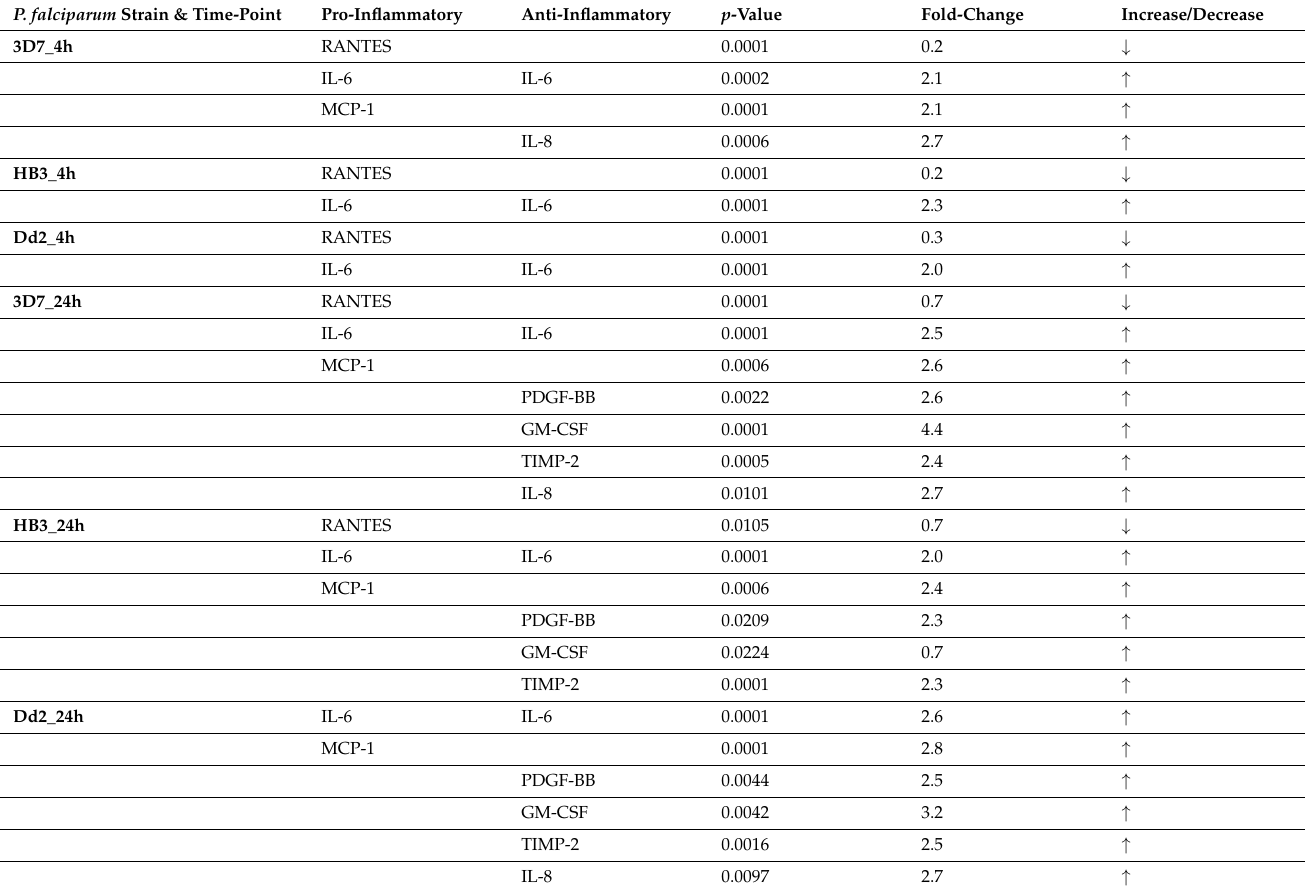
Table 1. Protein microarrays exhibiting a significantly altered inflammatory profile. Expression of cytokines and chemokines in the secretome resulting from HBMEC- P. falciparum parasite stimulation and TNF- α [20 ug/mL] at time points 4 h and 24 h, compared with NC. In addition, fold-change value, p -value, and if proteins are increasing ( ↑ ) or decreasing ( ↓ ) were